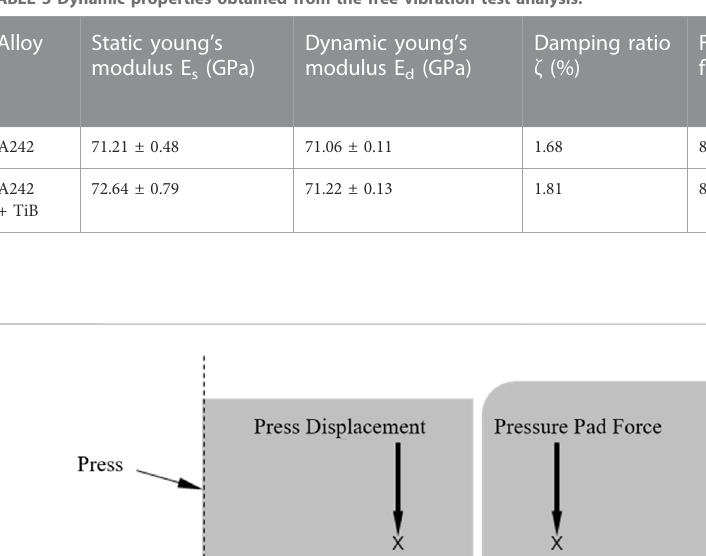
TABLE 3 Dynamic properties obtained from the free vibration test analysis.